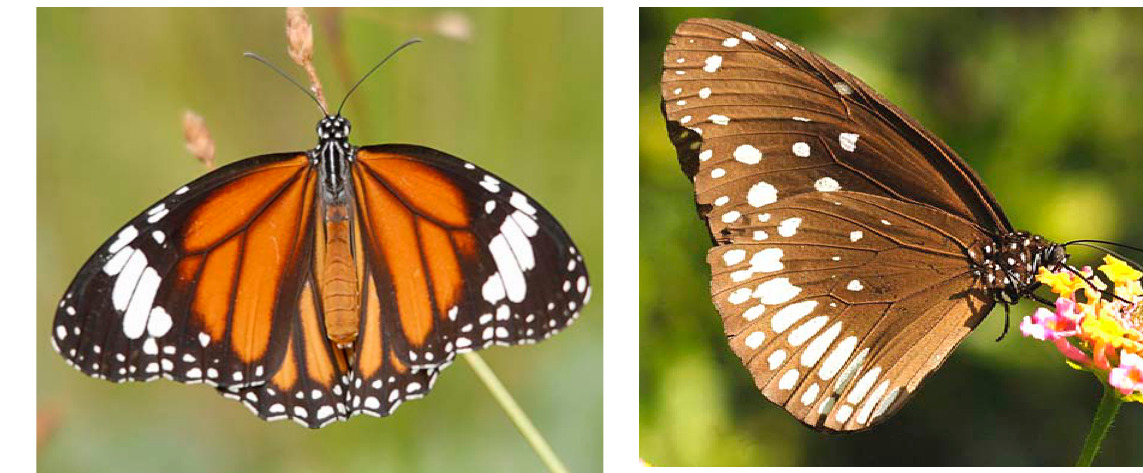
Image 10. Striped Tiger Danaus